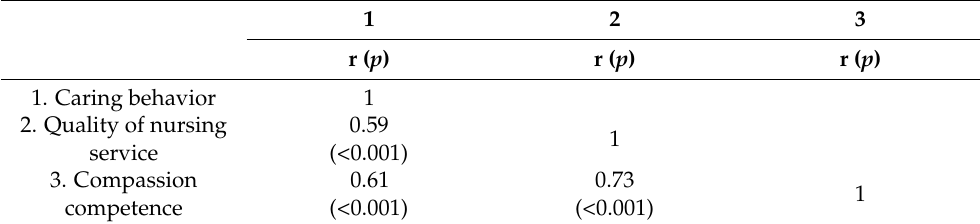
Table 2. Correlations among study variables ( N =